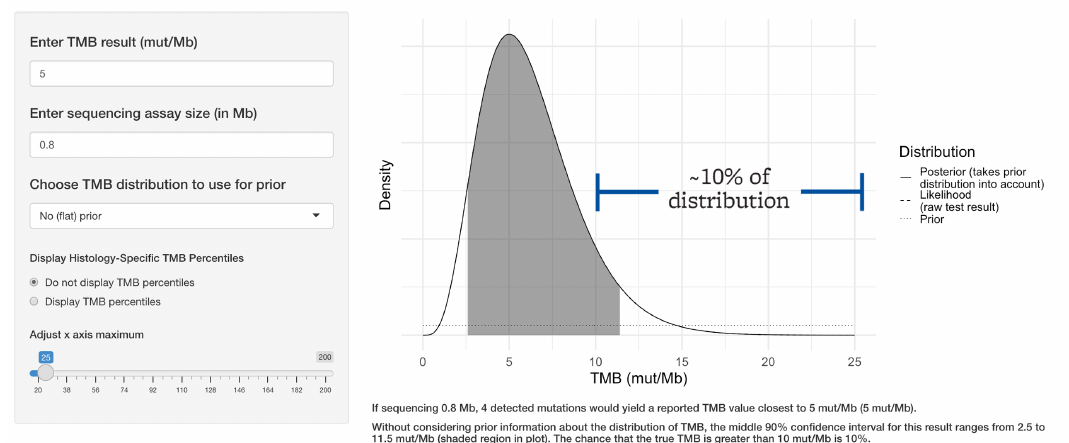
Figure 3. The threshold for clinical response to immune checkpoint inhibitor therapy is 10 mut/Mb based on TMB alone. FDA-approved companion diagnostic TMB assays sequence approximately 0.8 Mb. Even a common TMB-low value such as 5 mut/Mb generated by such an assay would indicate a true TMB value of greater than 10 mut/Mb approximately 10% of the time.